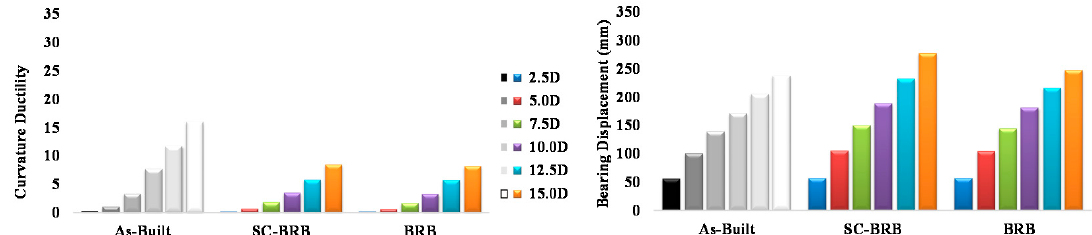
Figure 24. Observed CD ( left ) and BD ( right ) demands under near-field earthquake records when scaled to different design intensities.